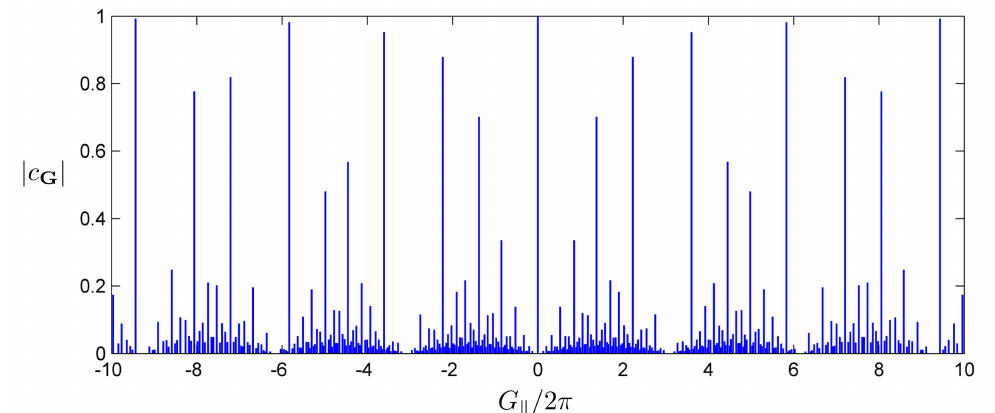
Figure 5. Diffraction pattern of the Fibonacci QC obtained by Fourier series (FS) expansion of the higher dimensional unit cell, as shown in Figure4b. Fourierharmonics (magnitude) are plotted versus the parallel component of the corresponding reciprocal vectors